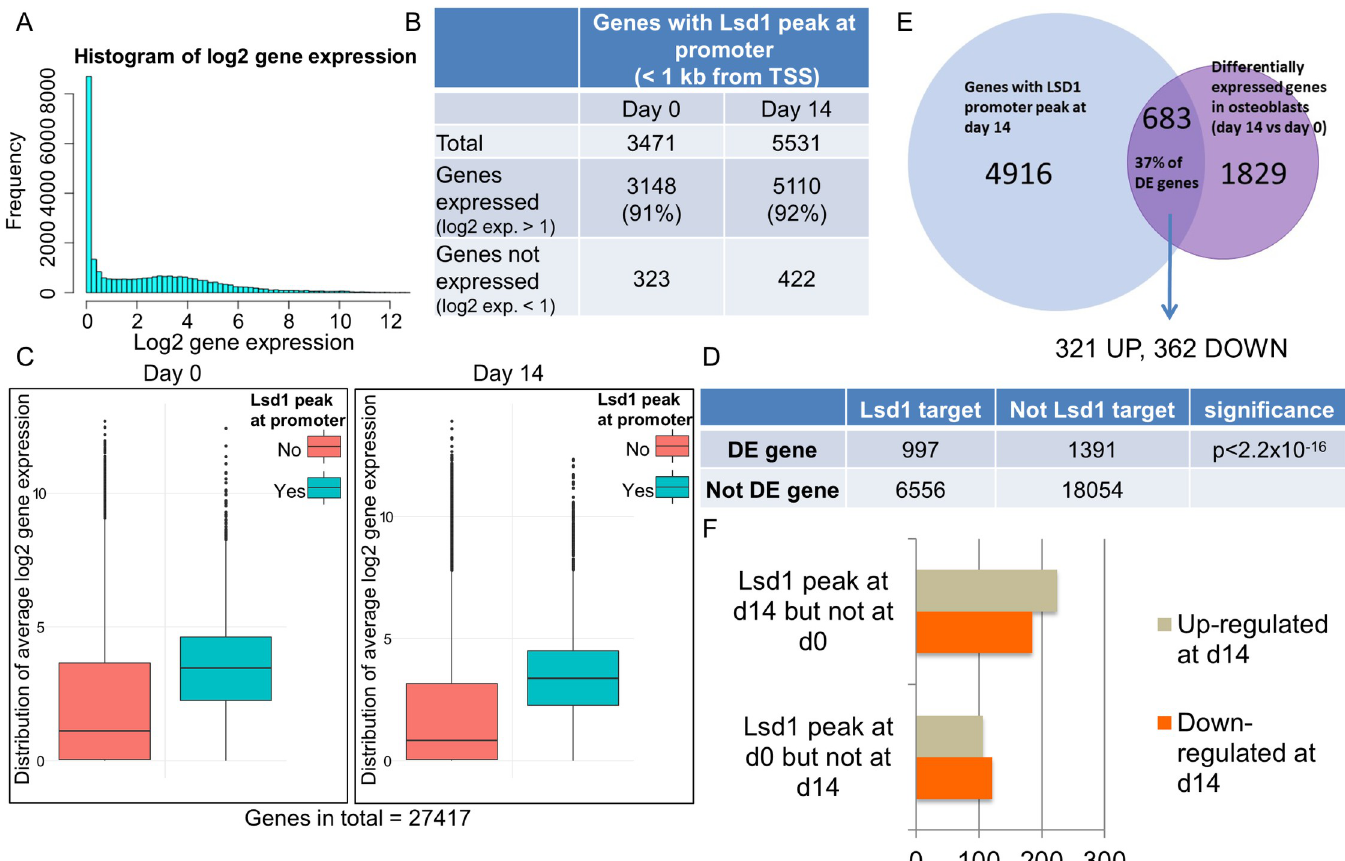
Fig 9. Lsd1 binding correlates with expression status and differential expression. (A) Determination of gene expression status of RNA-seq data. Genes with log2 expression level < 1 were defined as expressed. (B) Correlation between Lsd1 binding and gene transcriotion at 0 and 14 d of differentiation. (C) The average expression level of genes with (blue) or without (red) Lsd1 promoter occupancy at 0D and 14D timepoints. (D) Lsd1 binding was significantly enriched on the promoters of DE genes during differentiation. (E) DE genes with Lsd1 occupancy were equally up- and downregulated. (F) Dynamics of Lsd1 binding was not indicative of up- or downregulation of gene